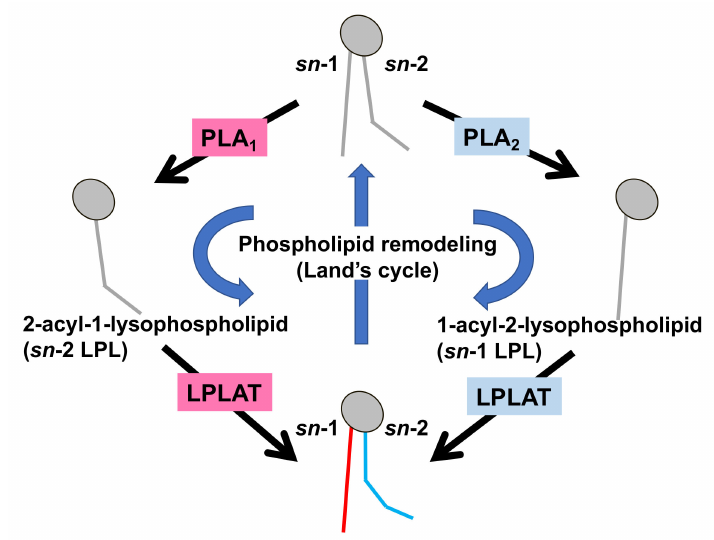
Figure 2. Fatty acid remodeling reactions of GPLs. Glycerophospholipids (GPL) in the cells are constantly subjected to two kinds of fatty acid hydrolyzing reactions mediated by phospholipase A